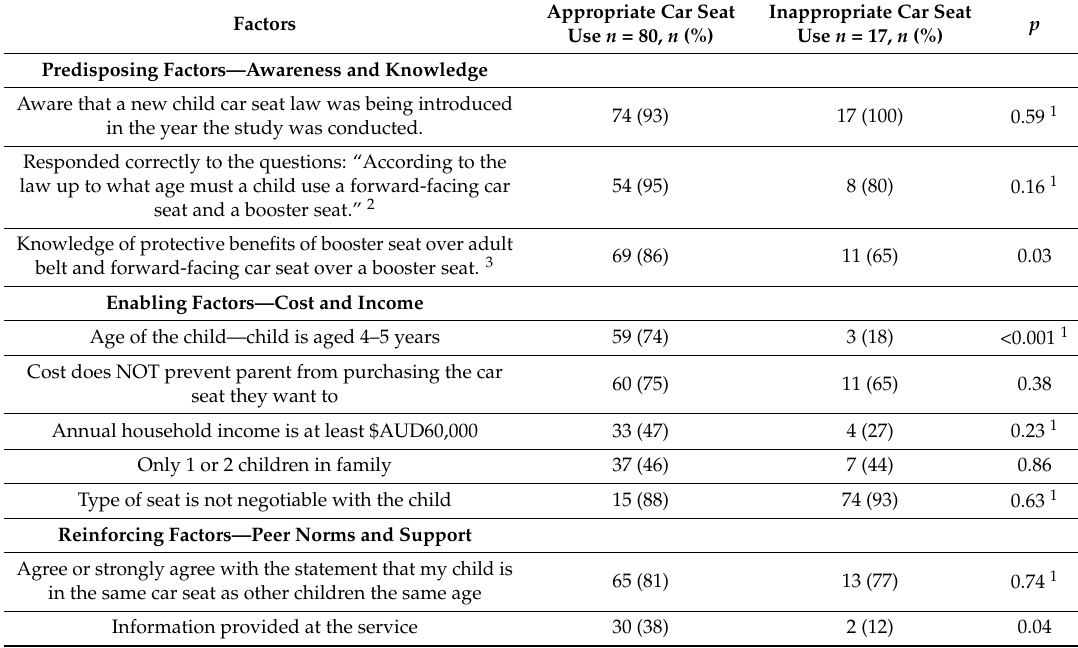
Table 2. Comparison of predisposing, enabling and reinforcing factors for car seat use between those reporting car seat use assessed to be age-appropriate and those reporting car seat use assessed to be inappropriate, for 97 children aged 2–5 years.